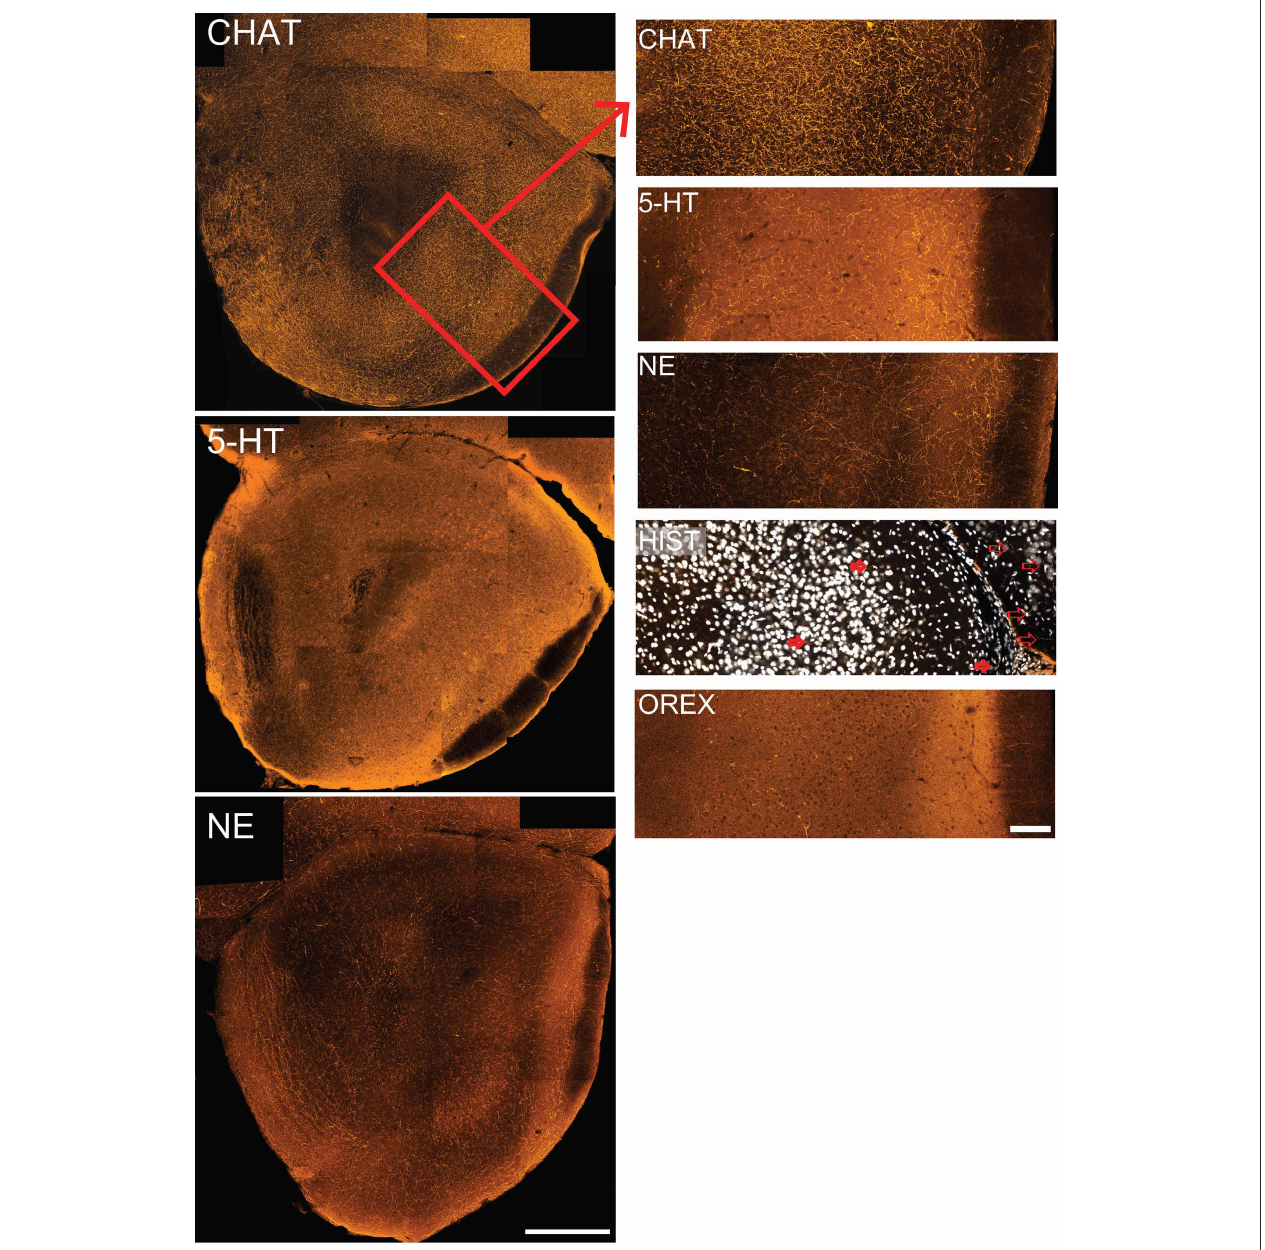
FIGURE 2 | The olfactory peduncle receives substantial input from neuromodulatory fibers. Coronal sections indicate different patterns of immunostaining for five neuromodulatory systems. Left column: composite confocal images of cholinergic (CHAT), serotonergic (5-HT) and noradrenergic (NE) fibers taken at a standardized location in the caudal peduncle. Histaminergic (Hist) and orexinergic (Orex) staining was too sparse to be seen at low magnifications. Medial to left, dorsal at top. Scale bar: 250 μ m. Box in top figure represents the